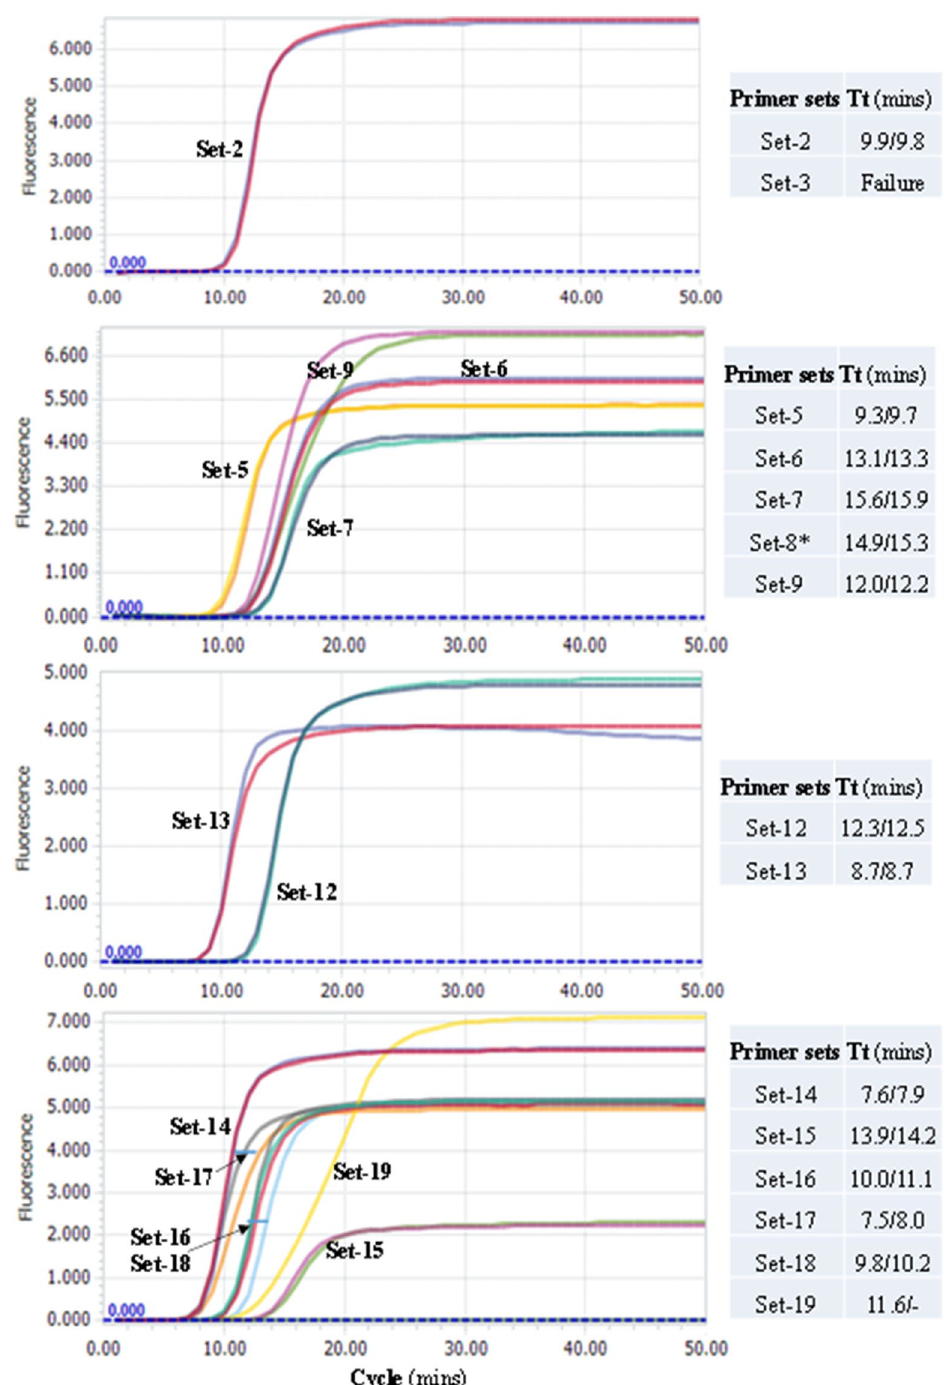
Figure 2. Comparison of performance of 15 RT-LAMP assays using RNA standards. Two replicates were performed for each primer set. The replicates of the same primer set often generated completely overlapped amplification curves. A short bar was used to highlight the non-overlapping curves of the same primer. The curves of non-template control (NTC) are not shown. *The Tt values of the Set-8 were obtained by another repeated comparative experiments with Set-5and Set-9, both of which showed a consistent trend, but slightly lower Tt values than those shown